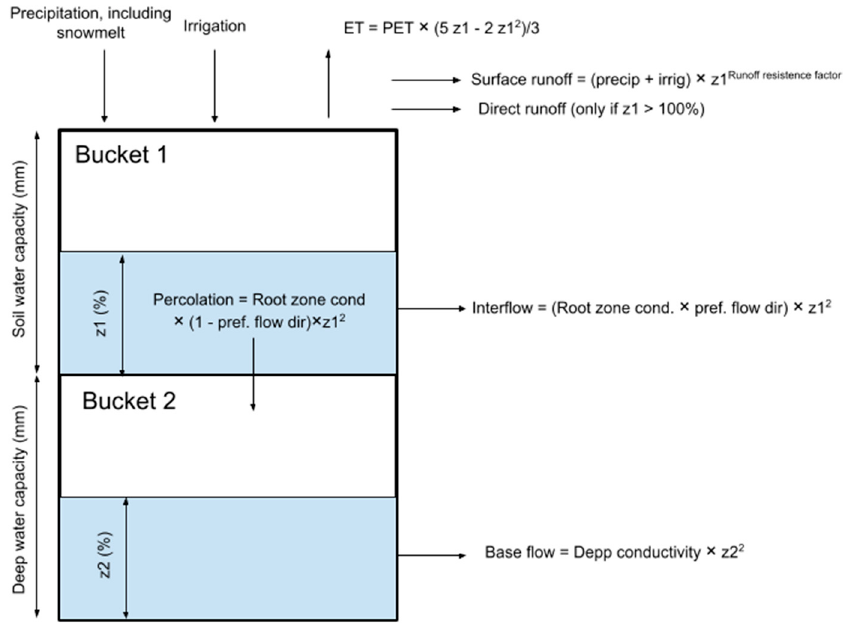
Figure 4. Conceptual scheme and equations of the soil moisture method [27].